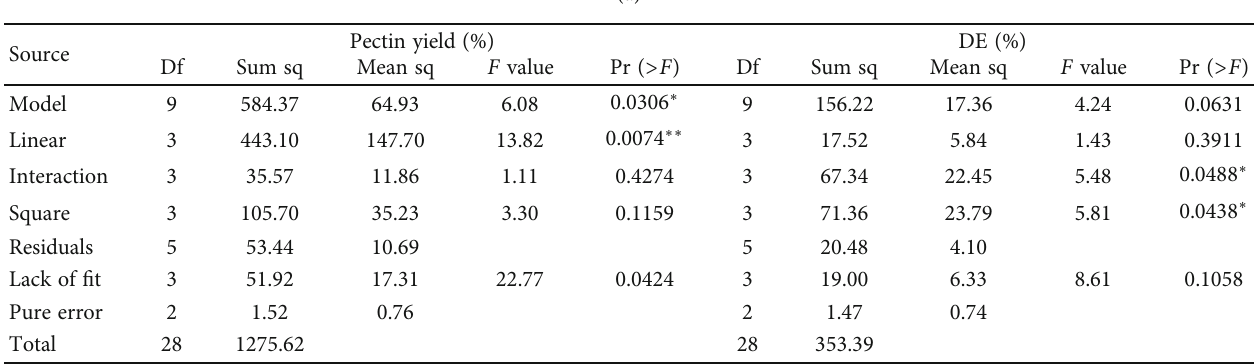
Table 3: Results of ANOVA for pectin yield, DE, MeO, and AUA.